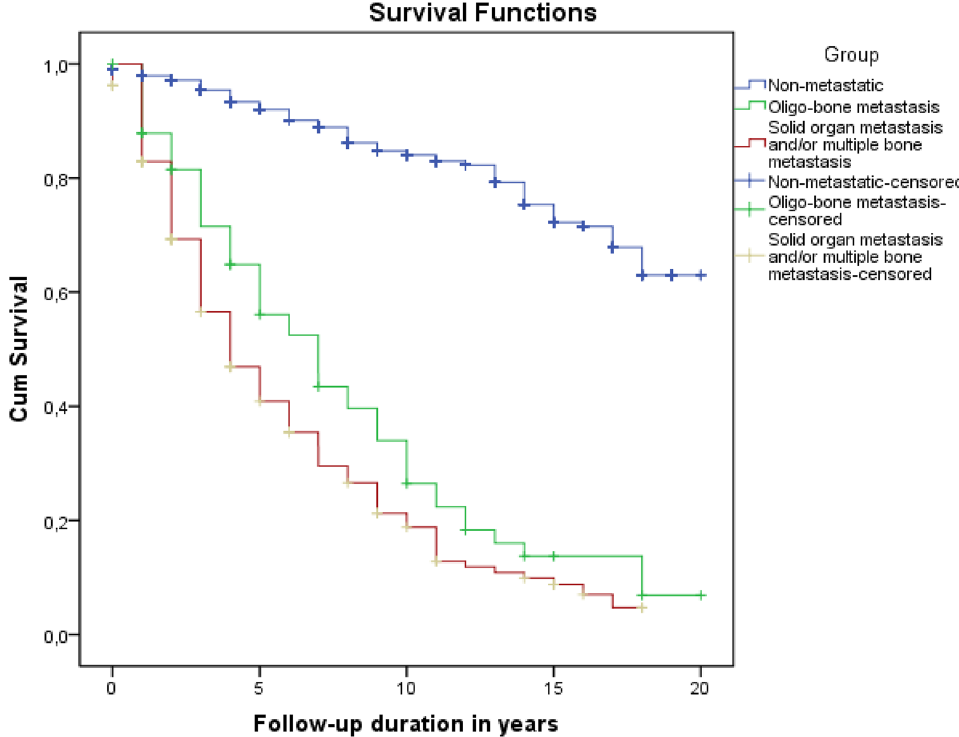
Figure 2. The overall survival of Groups 1, 2, and 3.